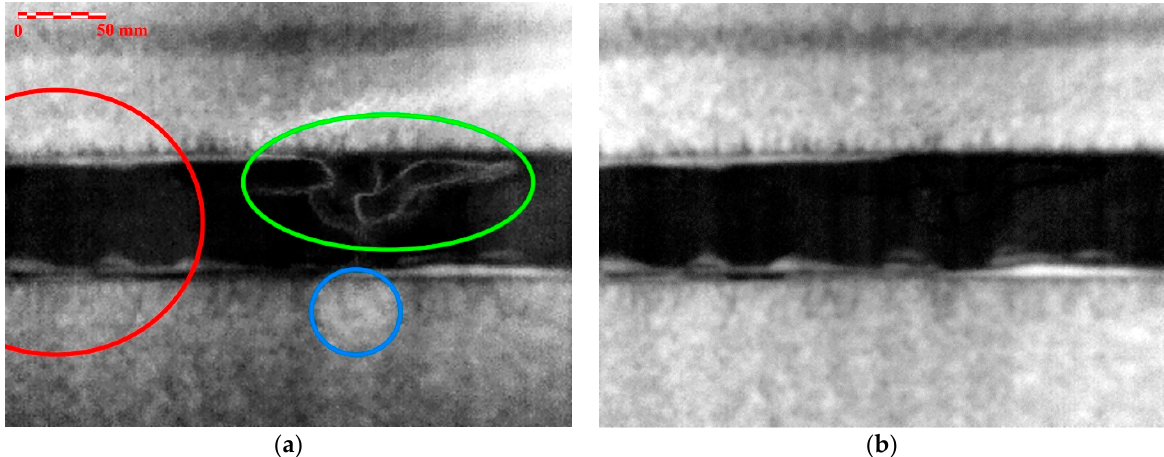
Figure 15. Comparison of the resulting images: ( a ) RAW thermal data; ( b ) modified DAC-processed data.